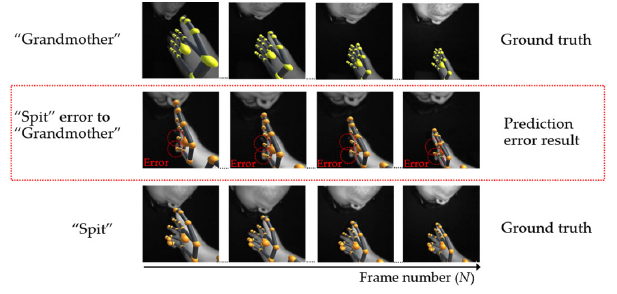
Figure 15. Example of an error caused by the